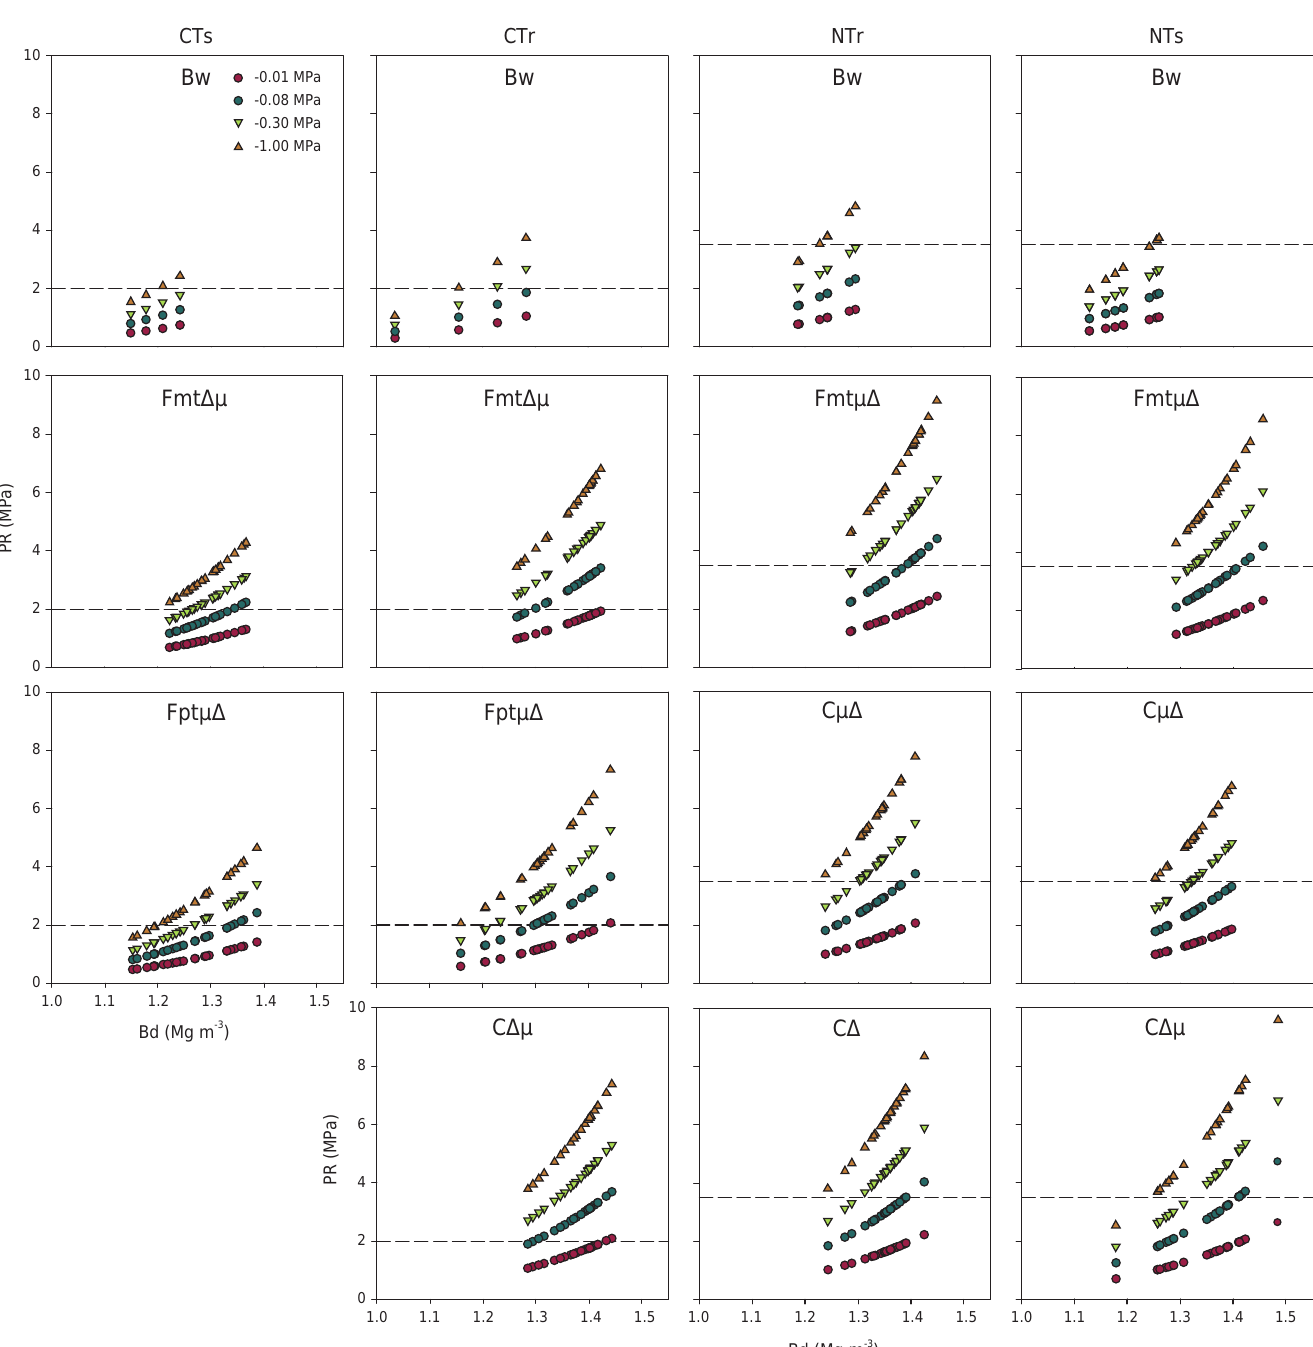
Figure 1. Soil penetration resistance (PR) as a function of soil bulk density (Bd) of the morphological units at four matric potentials in a Ferralsol under conventional tillage (CT) and no-tillage (NT) with crop rotation (r) and succession (s). The dashed line indicates the critical limit for penetration resistance of 2 MPa for conventional tillage and 3.5 MPa for